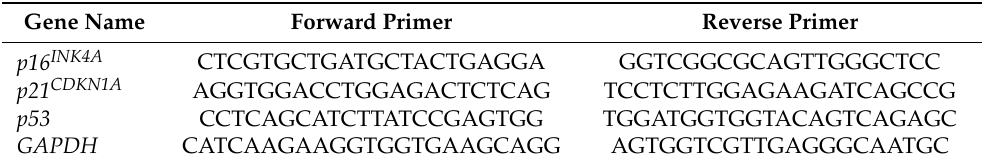
Table 1. Sequences of primers used real-time